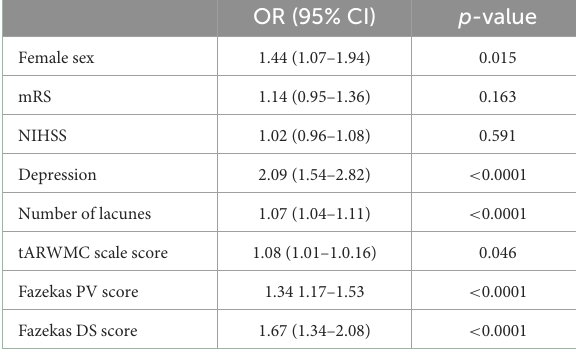
TABLE 3 Variables associated with CI at follow-up; univariate logistic regression analysis adjusted for age and vascular risk factors. OR (95% CI) p- value